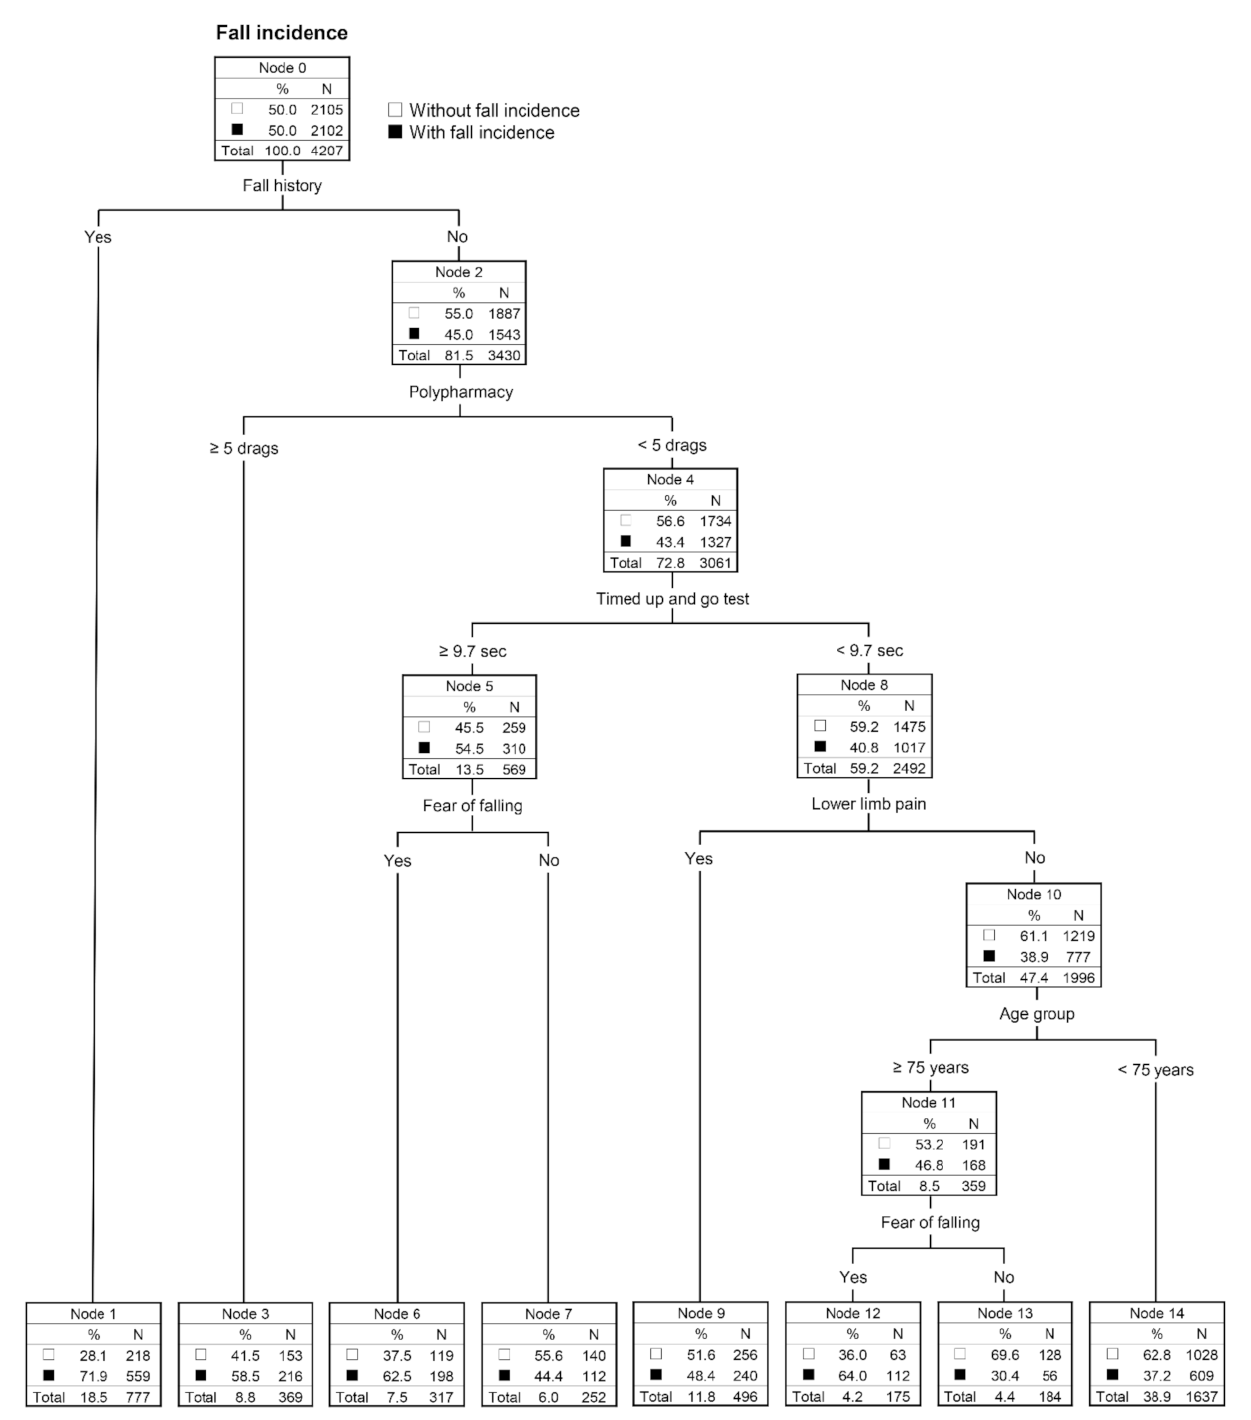
Figure 2. Decision-tree model for fall